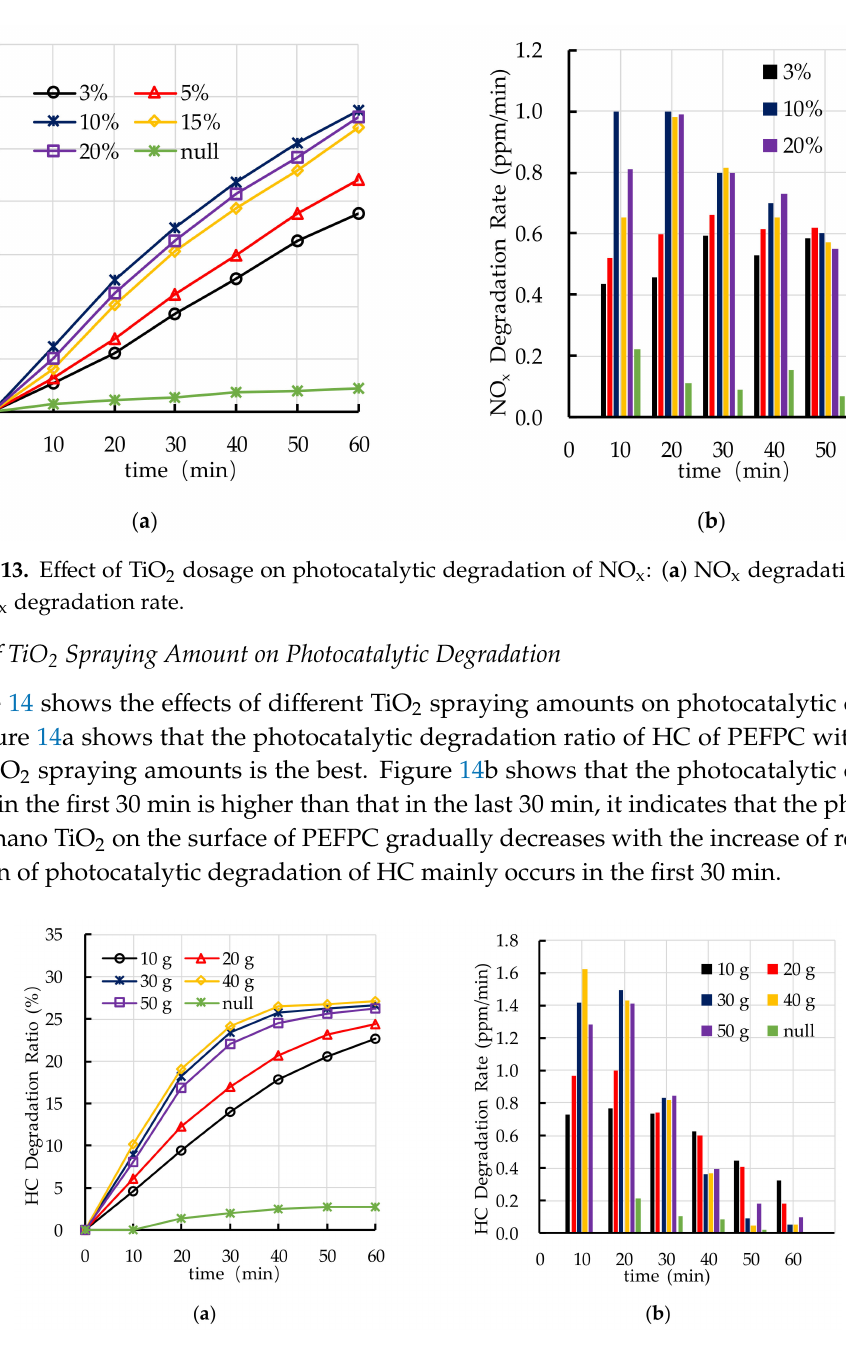
Figure 14. E ff ect of TiO 2 spraying amount on photocatalytic degradation of HC: ( a ) HC degradation ratio; ( b ) HC degradation